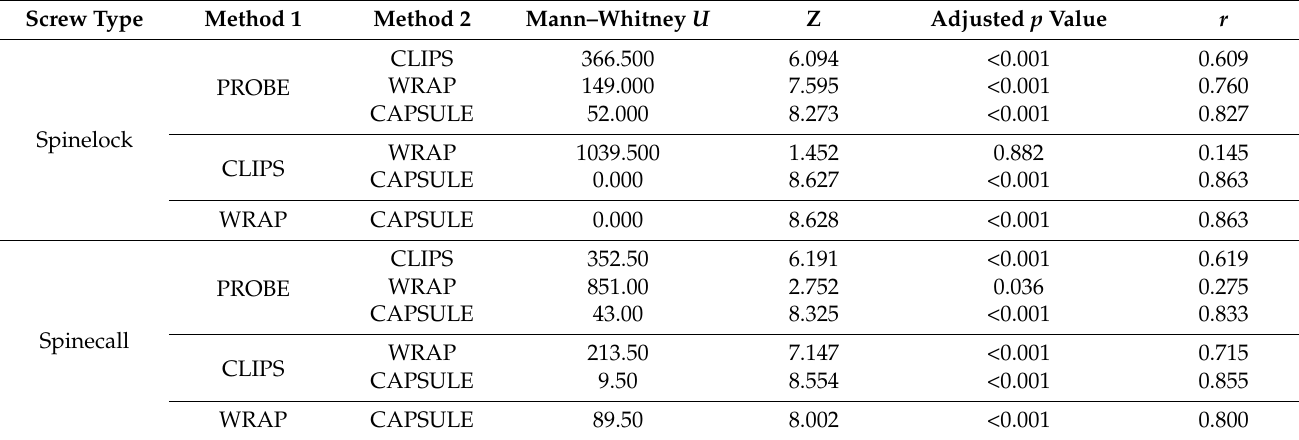
Table 2. Results of the statistical comparison of electrical resistance and resistivity obtained from each coupling method. Screw Type Method